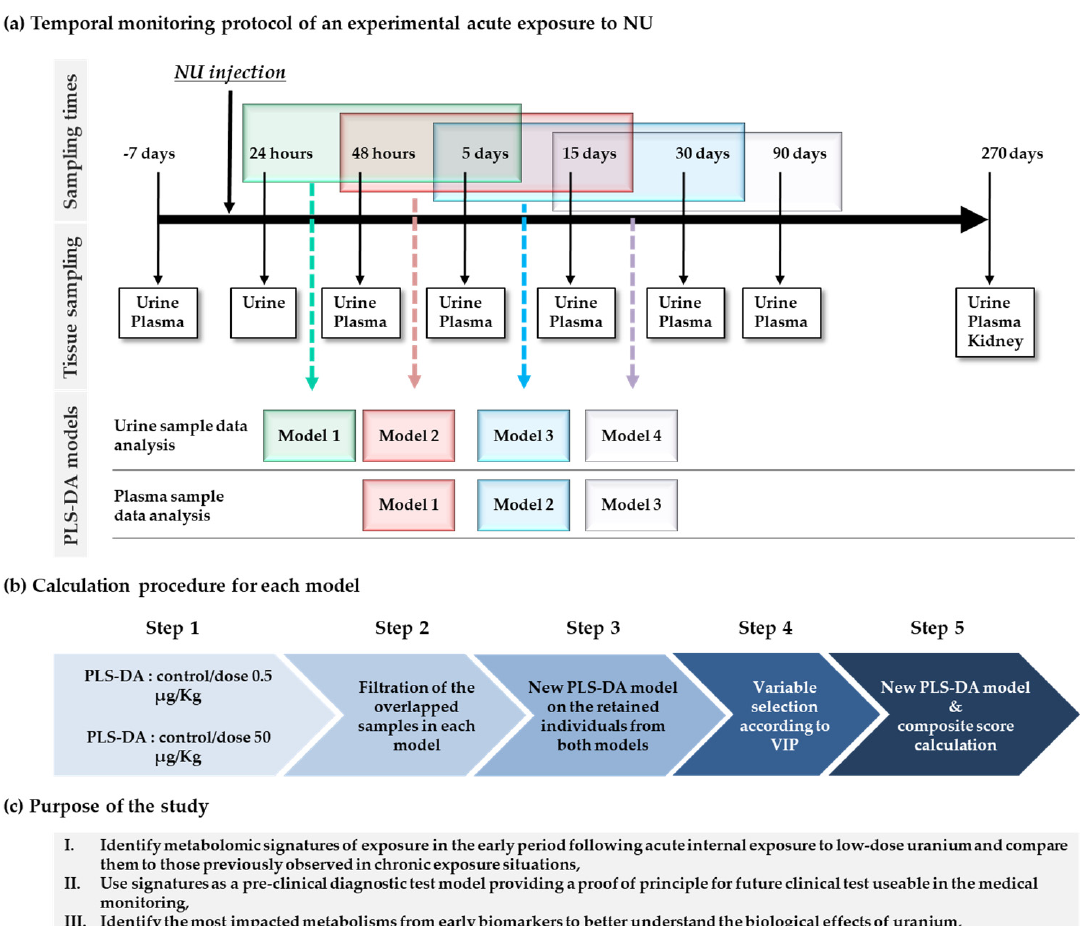
Figure 1. ( a ) Urine and plasma sampling times after acute exposure to NU and sampling time models defined for Partial Least-Squares Discriminant Analysis (PLS-DA). ( b ) Data processing pipeline patterns. ( c ) The main objectives of this study .